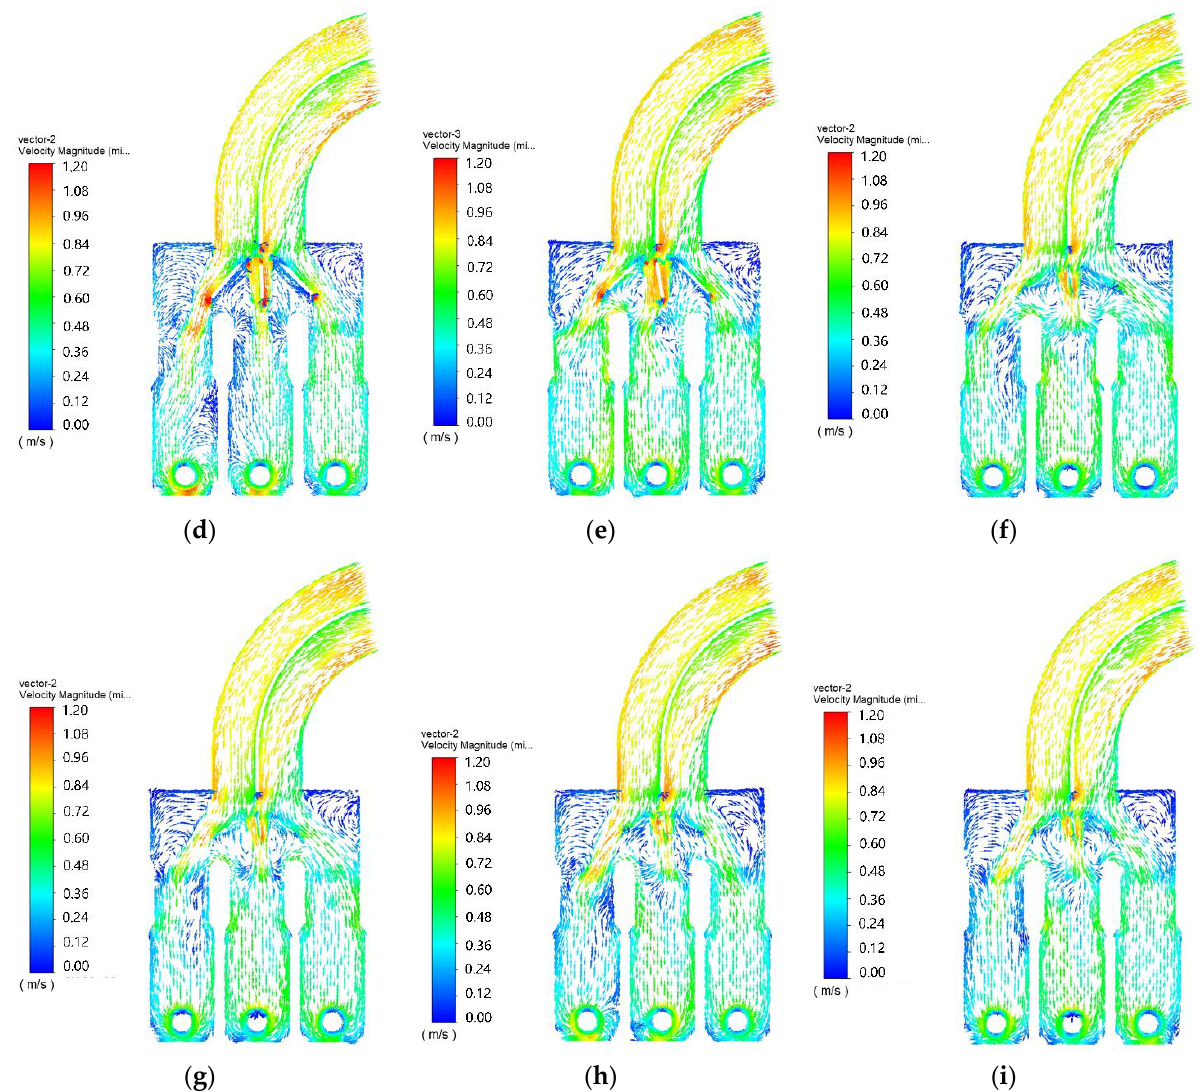
Figure 9. Velocity vector of overall flow field at 1.2 m . ( a ) Plan 2. ( b ) Plan 3. ( c ) Plan 4. ( d ) Plan 5. ( e ) Plan 6. ( f ) Plan 7. ( g ) Plan 8. ( h ) Plan 9. ( i ) Plan 10.